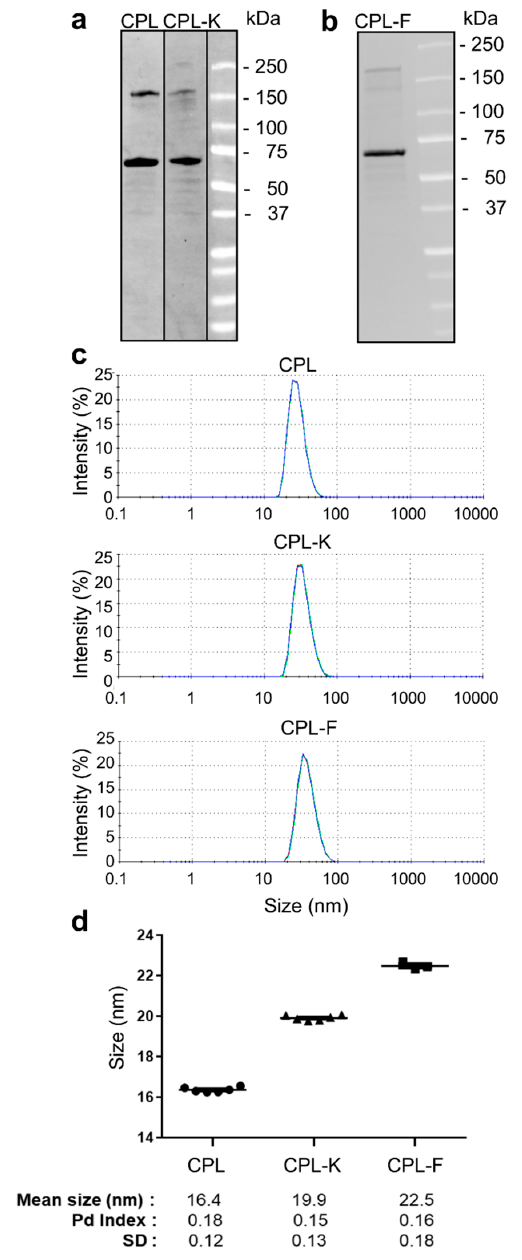
Figure 1. Analysis of CPL, CPL-K and CPL-F. ( a , b ) SDS-Page analysis of CPL, CPL-K ( a ), and CPL-F ( b ). The respective molecules are in the range of the estimated sizes of 59 kDa (CPL), 61 kDa (CPL-K) and 62 kDa (CPL-F). ( c ) Dynamic light-scattering (DLS) measurement of CPL, CPL-K and CPL-F. Measurements were performed three times independently for each of six samples per construct. ( d ) Mean particle sizes detected by DLS in the six samples per construct. Pd, polydispersion; SD, standard deviation.